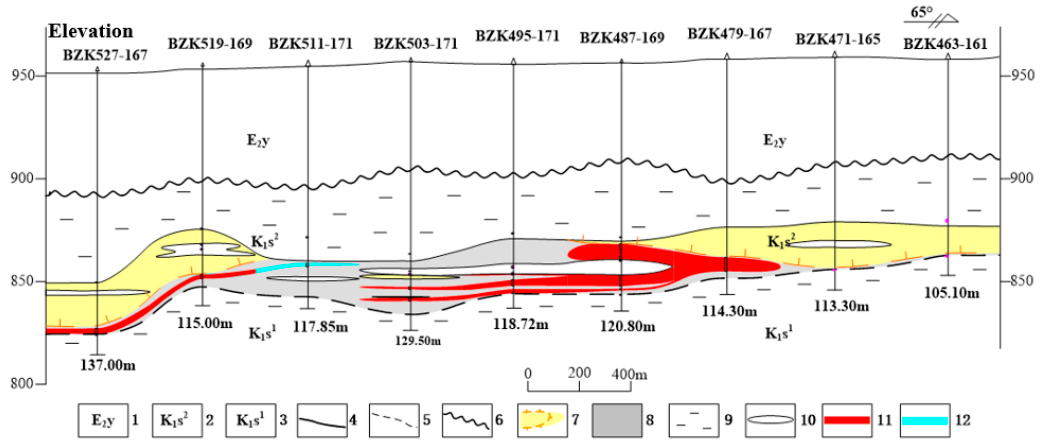
Figure 3. Statographic view of the Saihan Formation. (Note: 1—irdingmanha group; 2—upper part of Saihan group; 3—lower section of Saihan group; 4—lithological boundary; 5—parallel unconformity; 6—angle unconformity; 7—oxidation zone; 8—gray sandstone; 9—regional aquifers; 10—local aquifers; 11—uranium ore body; 12—uranium mineralized body).